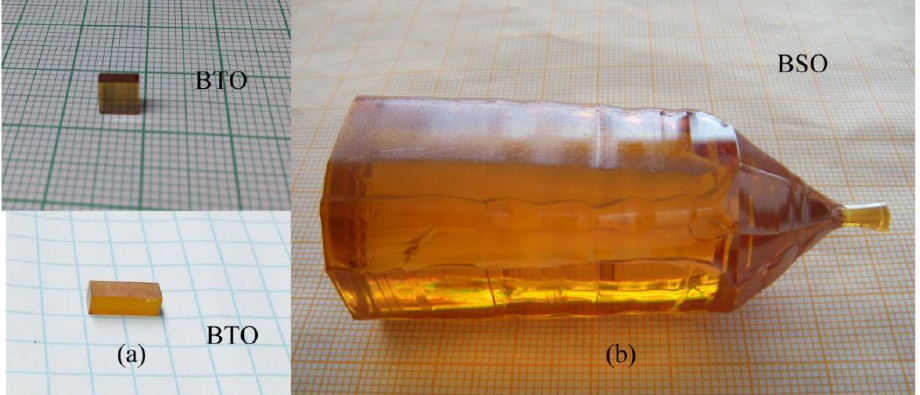
Figure 1. ( a ) The Bi crystal pulled along [110]